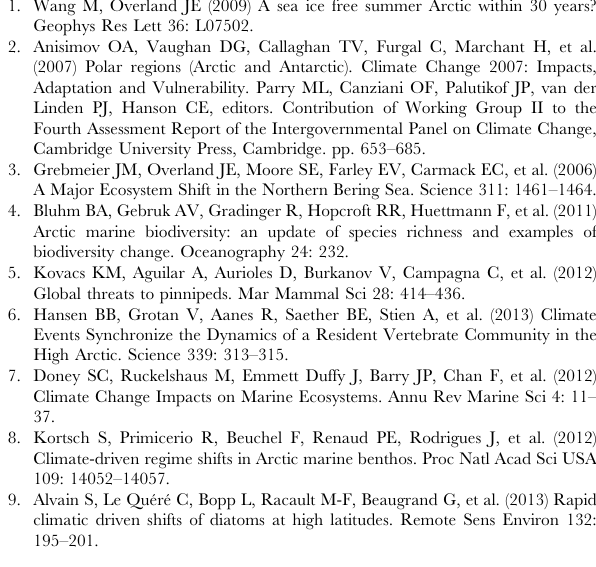
statistically significant differences in egg size (t-test, p , 0.05) or maturation stages between domains and years. Table S4 Summary output from a linear model for polar cod total length, explained by age, climatic domain as well as the interaction between age and domain. This model explained 65% of the variability in polar cod body length. Gender and all other interaction terms were omitted as explanatory variables after model simplification based on stepwise deletion of non-significant terms. P-values were smaller than 0.005 for all variables in the table. n= 281. Parameter estimate for intercept and slope in the table is for the Arctic domain. Intercept and slope for the Atlantic is obtained by adding the estimates for domain and the interaction term. Table S5 Percentage female polar cod per age class (total n per age class) from the Arctic domain stations (upper panel) and Atlantic domain stations (lower panel). Age classes are derived from the linear regression presented in Fig 3. Fish , 10 cm in length were excluded.